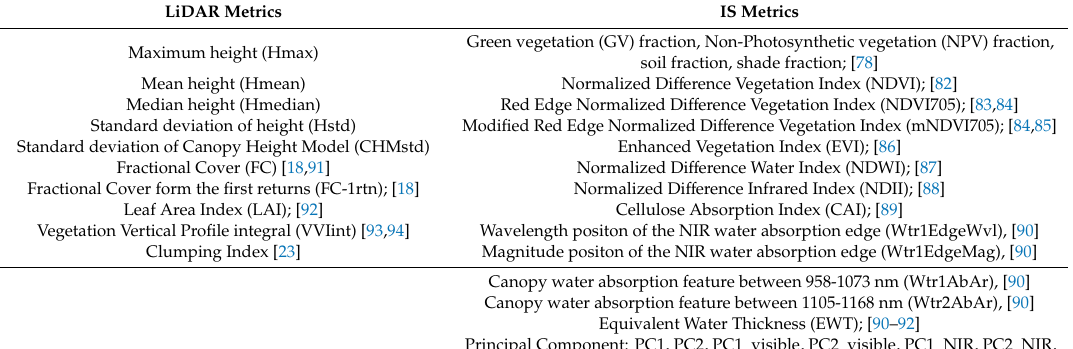
Table 1. Light detection and ranging (LiDAR) and imaging spectroscopy (IS) metrics considered in the development of the structural